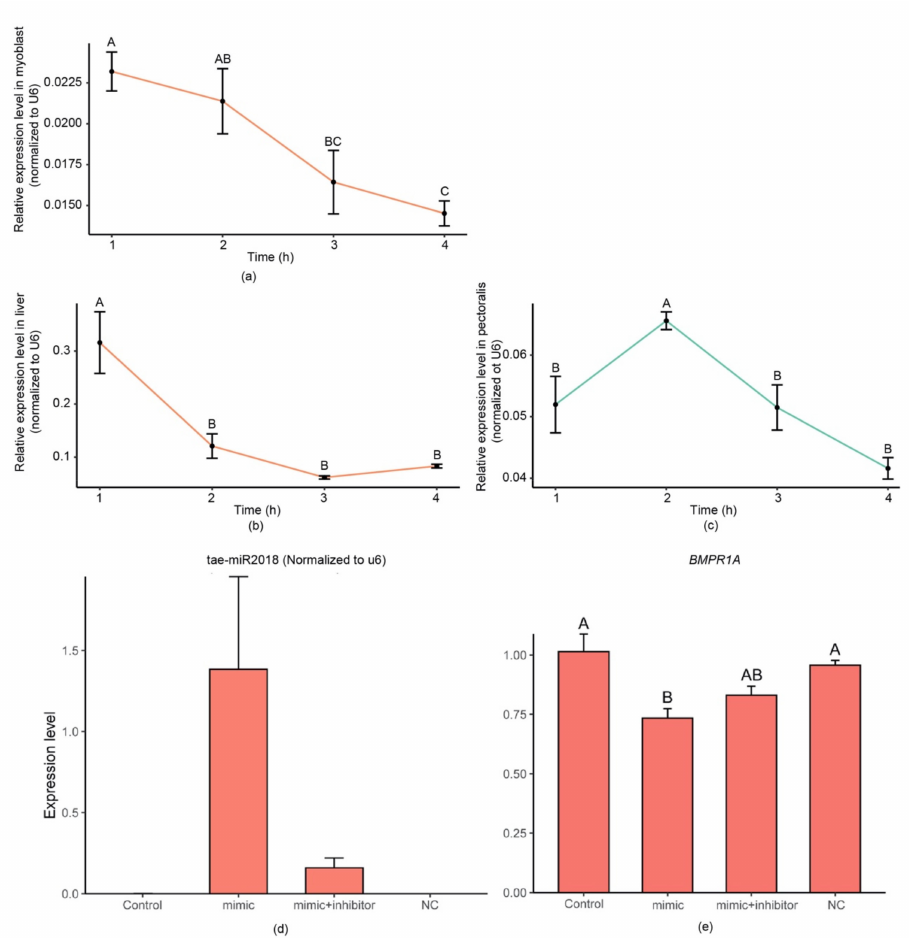
Figure 4. Expression levels of tae-miR2018 . Relative expression levels of tae-miR2018 in myoblasts ( a ) after incubation with synthetic tae-miR2018 and in the liver ( b ) or pectoralis ( c ) of chickens at the indicated time points after gavage feeding of synthetic dietary miRNAs. One-way ANOVA with the Tukey method was used to evaluate significance ( p < 0.001); ‘h’ means hour. Expression levels of tae-miR2018 ( d ) and BMPR1A ( e ) in chicken myoblasts transfected with wild type, tae-miR2018 mimic, tae-miR2018 mimic, and inhibitor ncRNA